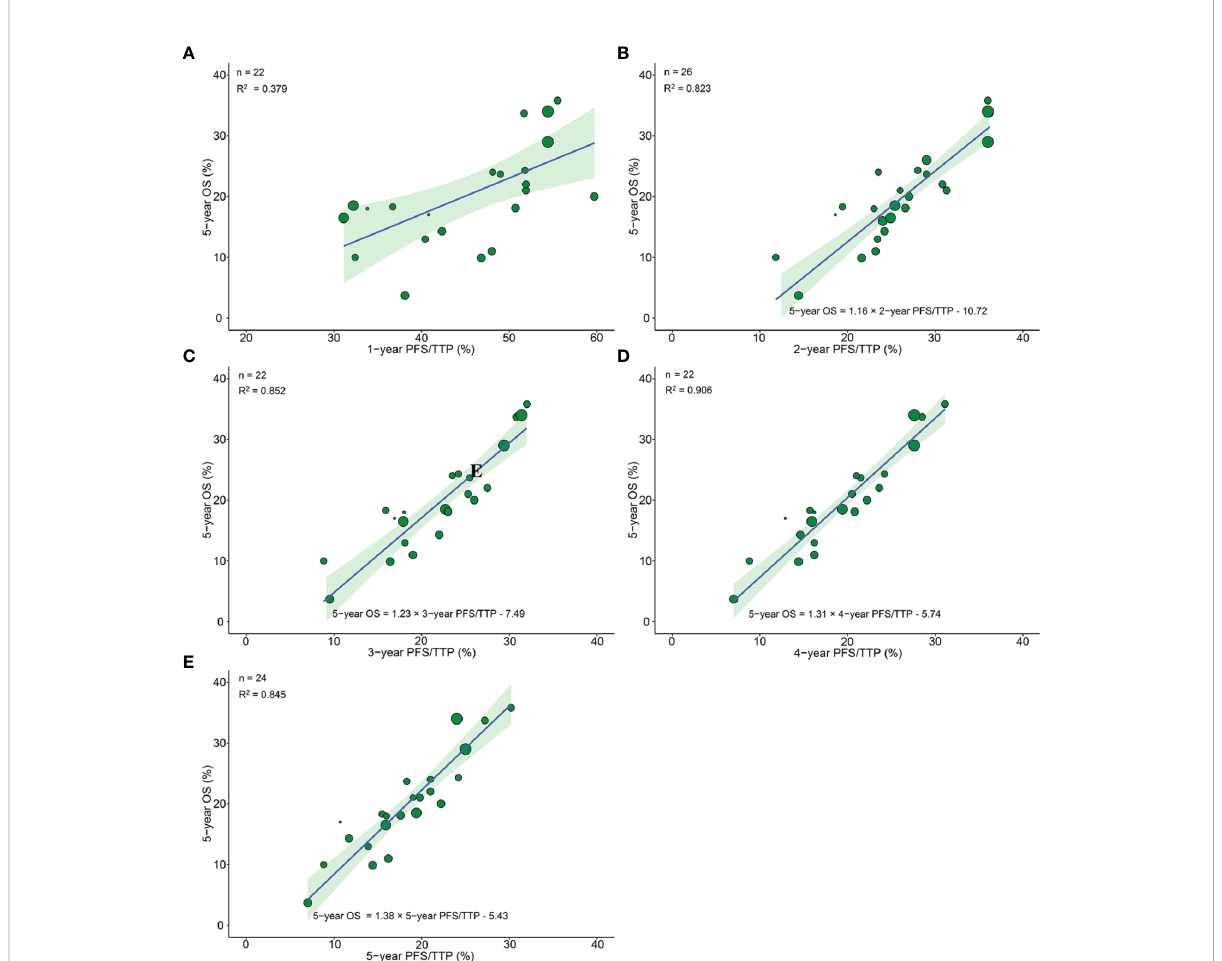
FIGURE 3 Treatment arm-level correlation between 5-year OS and 1-year PFS/TTP (A) , 2-year PFS/TTP (B) , 3-year PFS/TTP (C) , 4-year PFS/TTP (D) , 5-year PFS/TTP (E) in phase III RCTs. Green circles represent treatment arms with a size proportional to the number of patients, blue lines for the estimated regression lines and the light green zones for 95% con fi dence intervals. OS, overall survival; PFS/TTP, progression free survival/time to progression; RCTs, randomized controlled